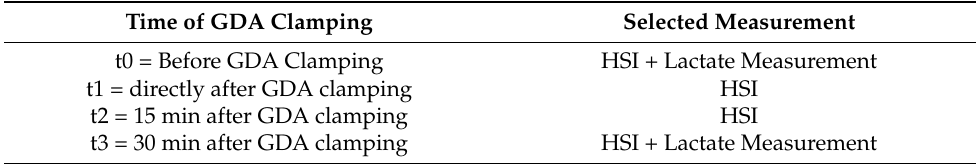
Table 2. Measurement steps (T = time point) according to the study